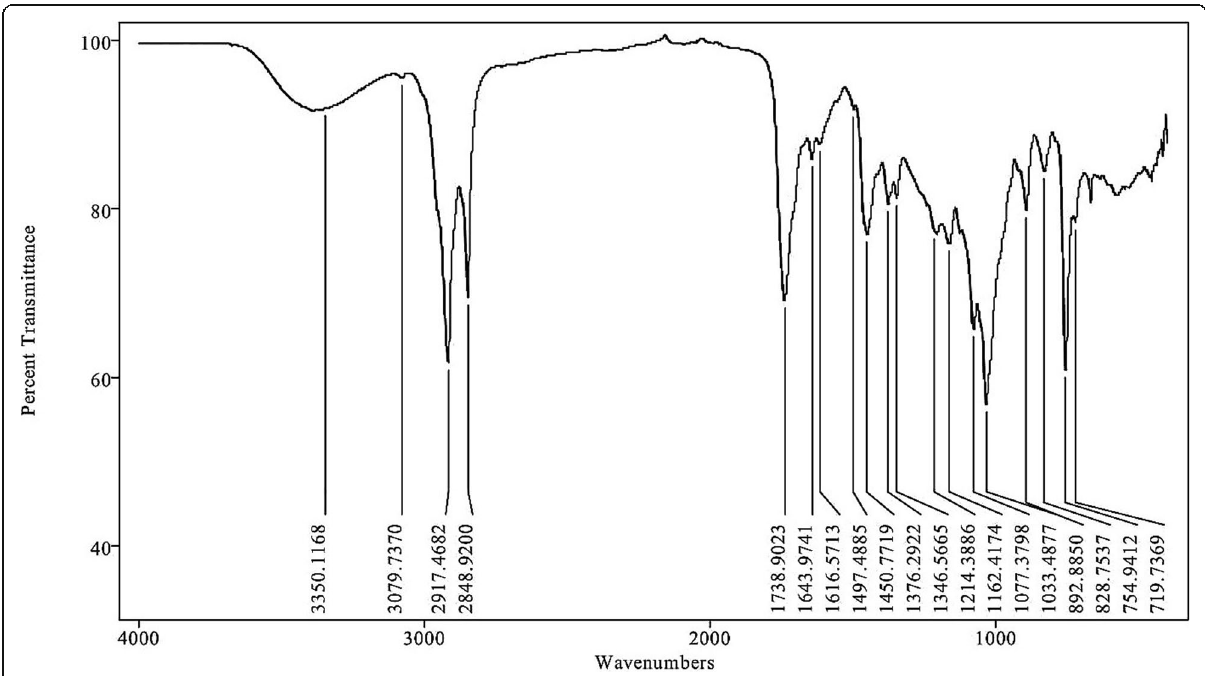
Fig. 3 FTIR spectrum of chloroform extract of Andrographis paniculata whole plant